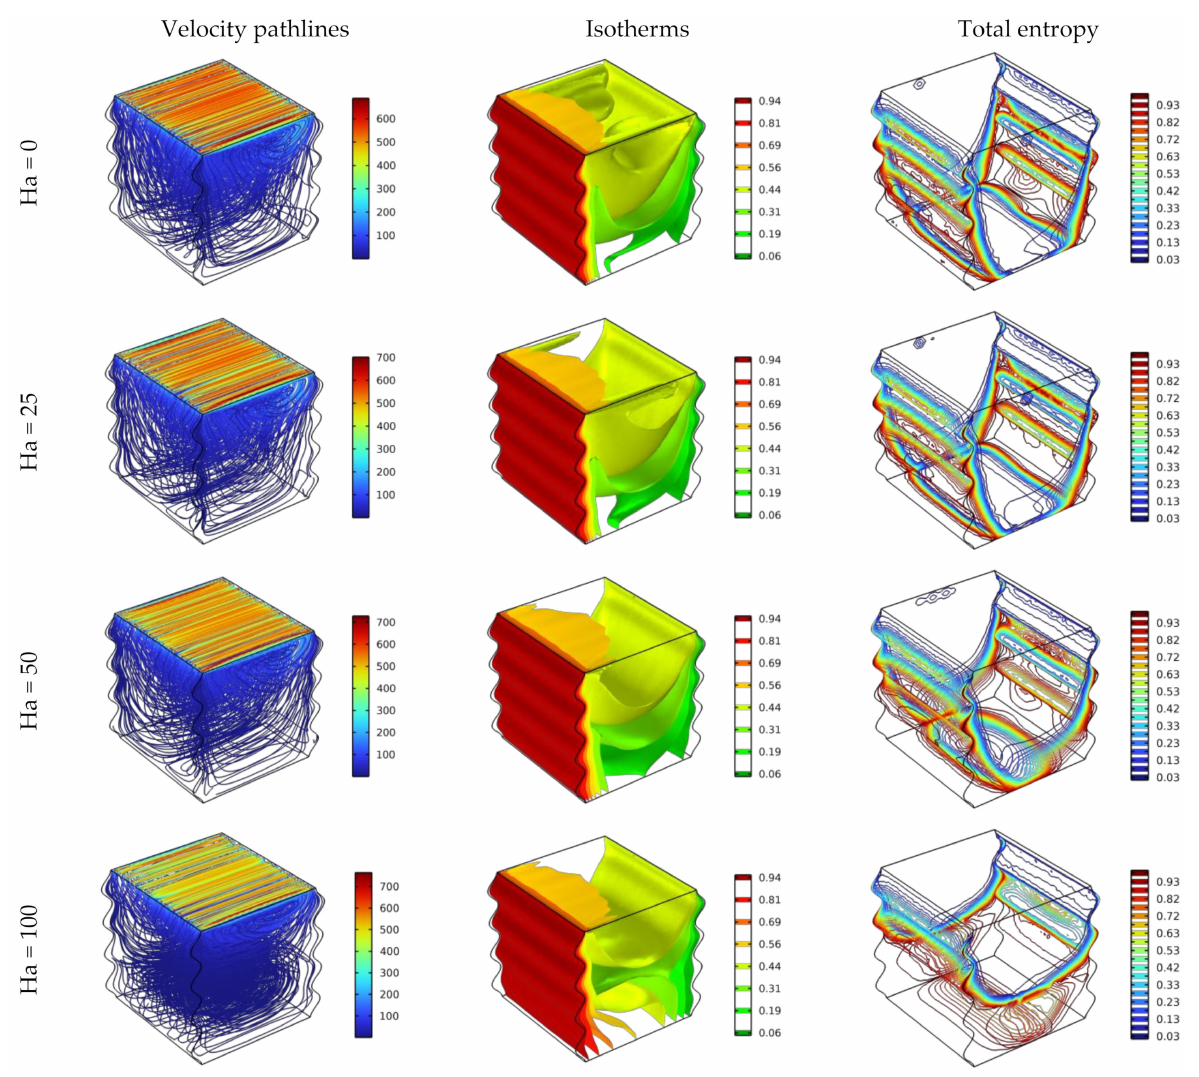
Figure 4. Distribution of the streamlines, isotherm, and total entropy for different Ha for Da = 10 –2 , ϕ = 0.04, and Re =